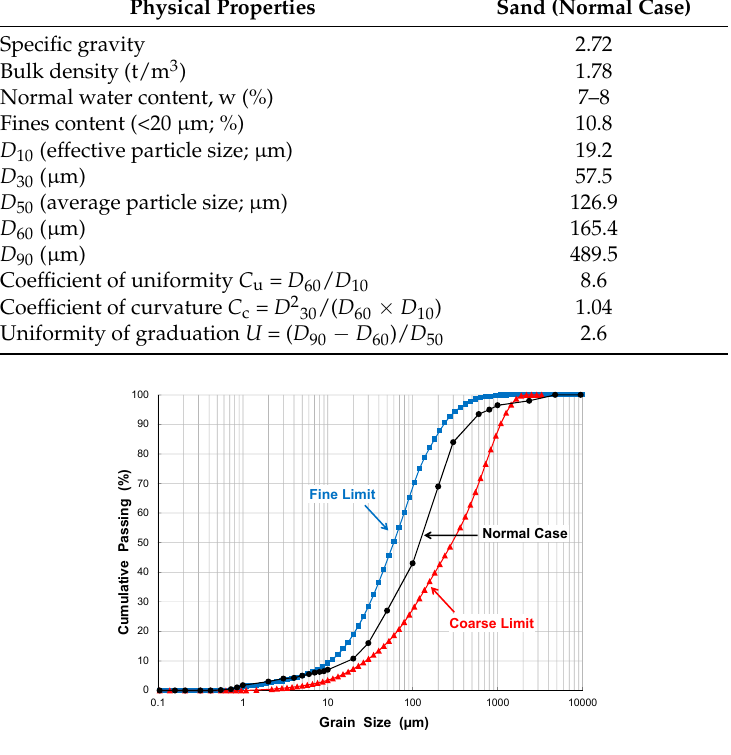
Figure 2. The particle size distribution (PSD) of alluvial sand used at Totten Mine.